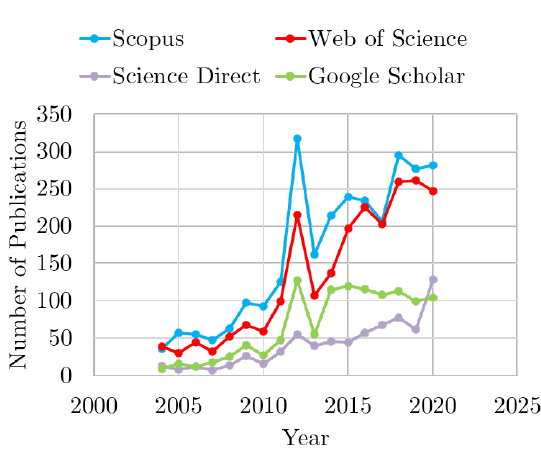
Figure 1. Number of publications on the topic of unfired earth in individual